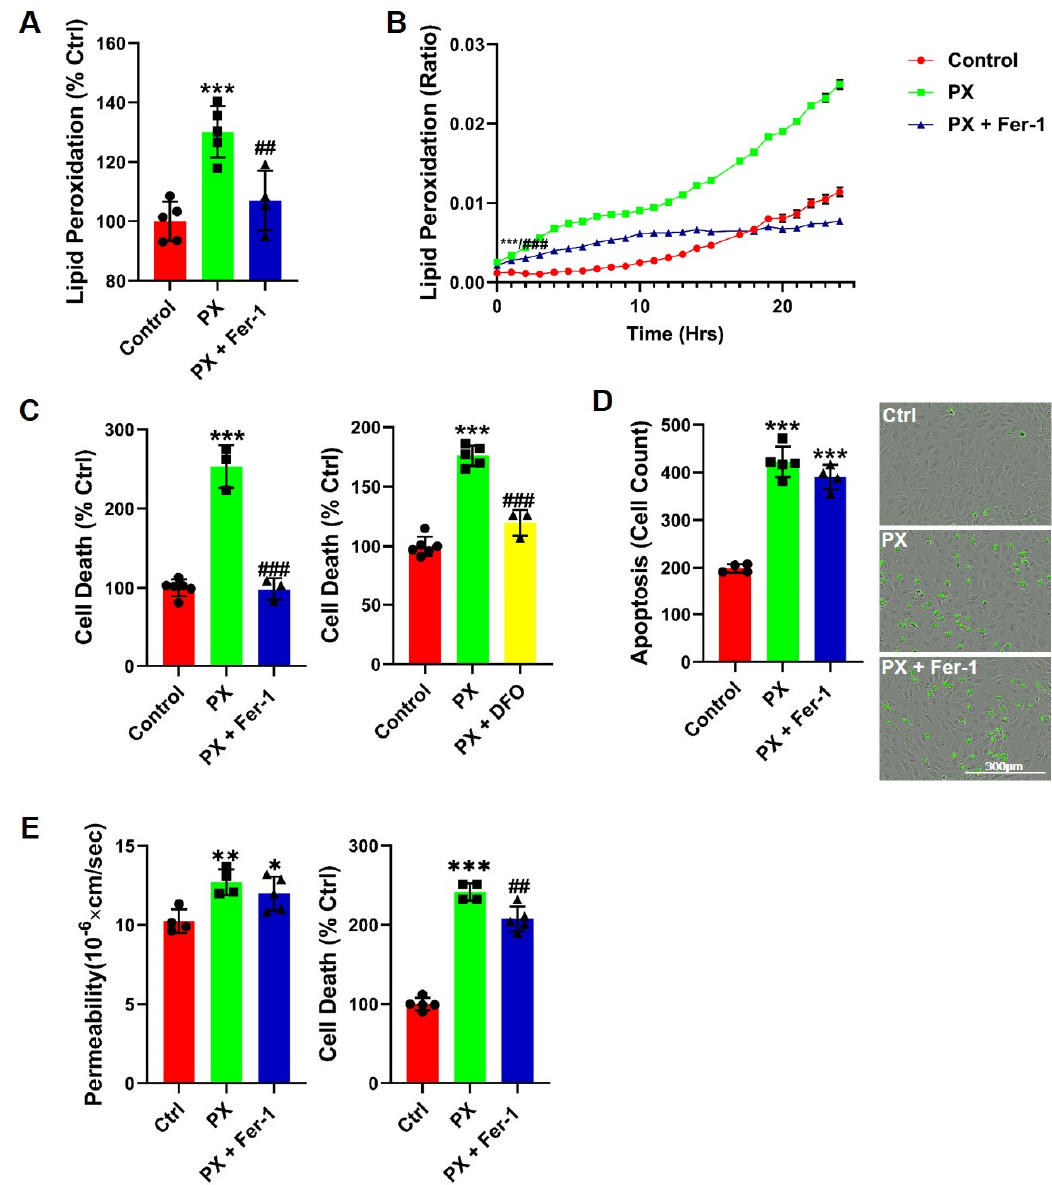
Figure 1. Inhibition of lipid peroxidation rescues cell viability but not barrier function. ( A ) Cellular lipid peroxidation 1-h subsequent to 400 µM PX treatment on a BLEC monolayer. Fer-1 was added at 50 µM. Ctrl are cells cultured with normal medium without the addition of any treatments. Mean ± s.d. of one representative experiment is shown, out of three independent experiments with n = 9–12, *** p < 0.001 vs. ctrl and ## p < 0.01 vs. PX; ( B ) Cellular lipid peroxidation was assessed by live cell imaging assay over a 24-h period on a BLEC monolayer. Mean ± s.d. of n = 4–6 for each condition from a single experiment, *** p < 0.001 vs. ctrl and ### p < 0.001 vs. PX marks the first time point with a significant change; ( C ) Cell death was assessed by the release of lactate dehydrogenase (LDH) 24-h post 400 µM PX treatment on a BLEC mono- layer. Fer-1 was added at 50 µM and DFO was added at 50 µg/mL. Mean ± s.d. of one representative experiment is shown, out of three independent experiments with n = 10–18, *** p < 0.001 vs. ctrl and ### p < 0.001 vs. PX; ( D ) Apoptosis was measured with a caspase-3 activated fluorescent marker by live cell imaging 24-h post PX treatment on a BLEC monolayer. Mean ± s.d. of one representative experiment is shown, out of three independent experiments with n = 9–12, *** p < 0.001 vs. ctrl marks the first time point with a significant change; ( E ) Permeability of sodium fluorescein (NaF) was measured across the BBB in vitro model (from luminal to abluminal side) 24-h post PX treatment. PX was added at 900 µM and Fer- 1 was added at 50 µM. Cell death was assessed by sampling medium from the luminal side with the LDH assay. Mean ± s.d. of one representative experiment is shown, out of three independent experiments with n = 9–15, * p < 0.05, ** p < 0.01 and *** p < 0.001 vs. ctrl and ## p < 0.01 vs. PX. Ctrl, control; PX, paraoxon; Fer-1, Ferrostatin; DFO, Desferal.